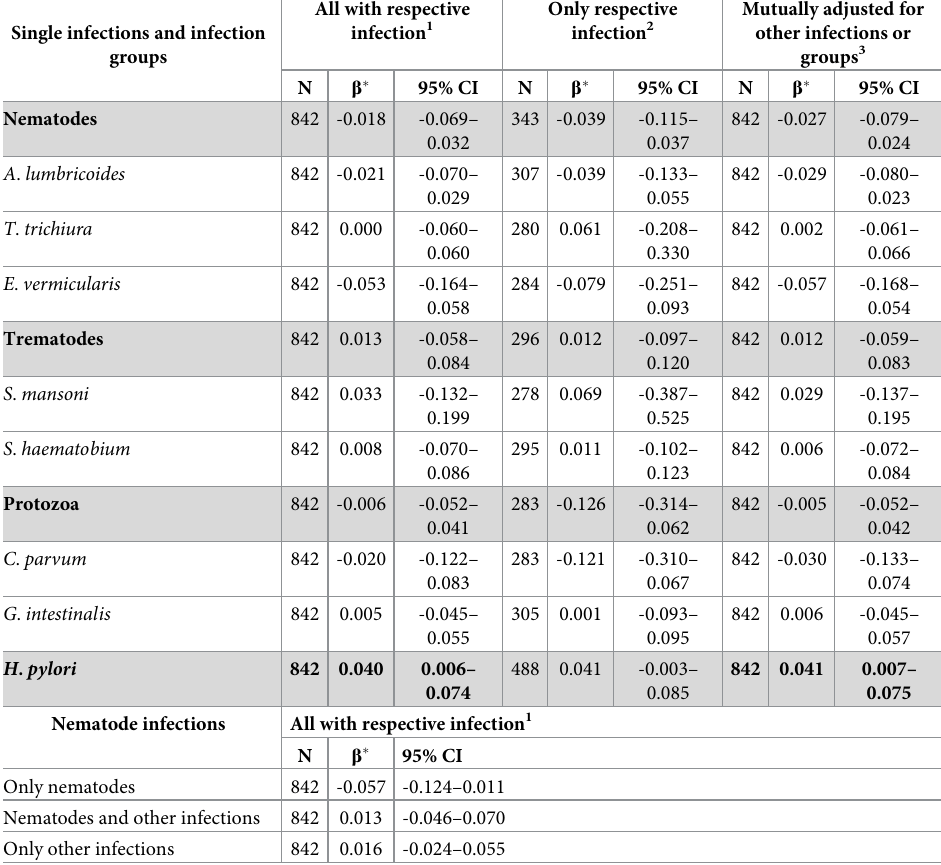
Table 3. Adjusted associations of infection with HbA1c at baseline. Single infections and infection